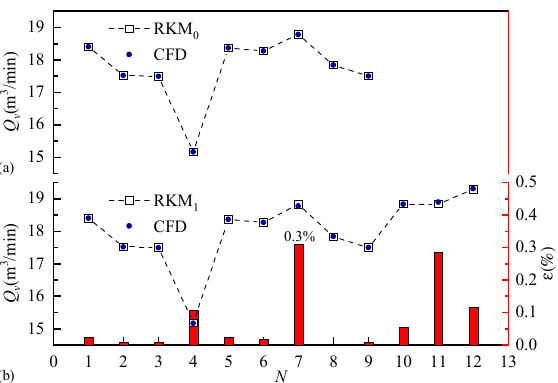
Figure 11. The prediction results of RKM for sample points in the initial stage: ( a ) initial sample; ( b ) sample after first filling. Table 5. Filling process of RKM in the initial stage.